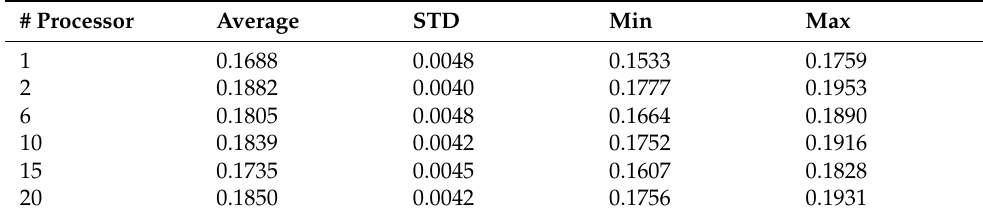
Table 5. HV results for Pareto solution found in different